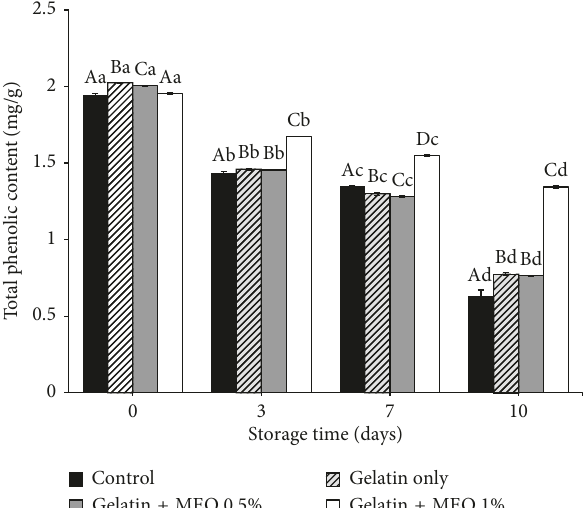
Figure 3: Total phenolic content (TPC) of coated and uncoated strawberries during storage at 4 ° C for 10 days. Vertical bars represent the standard deviation ( n � 3). Bars with different small letters indicate significant differences due to storage time ( p ≤ 0 . Table 2: Firmness and color of coated and uncoated strawberries during storage at 4 ° C for 13 days. Storage time (days)